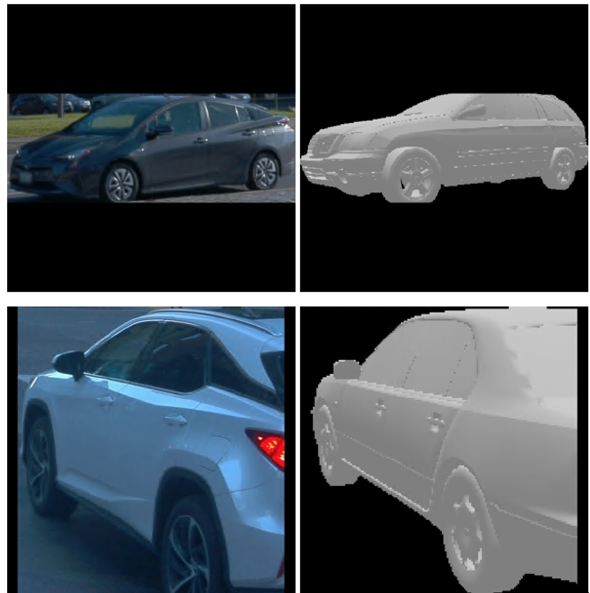
Figure 4. Waymo car patches (left) and corresponding rendered ShapeNet models (right) own model for 50 epochs from scratch using the paired Waymo